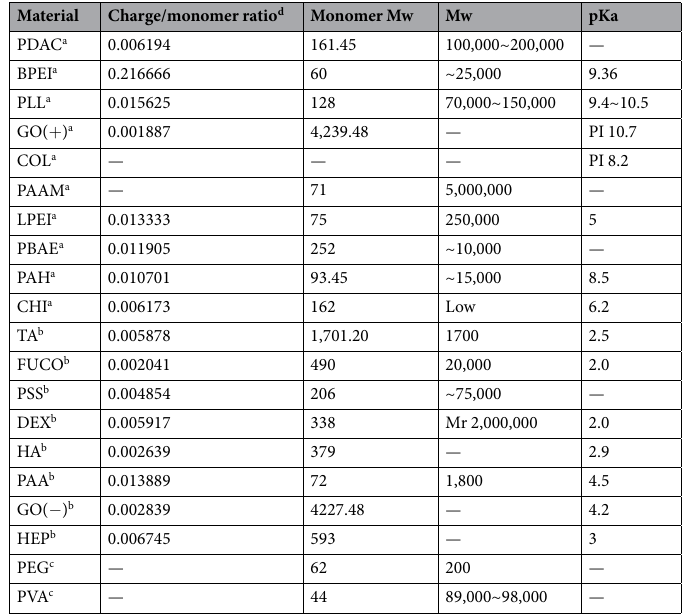
Table 1. Physicochemical properties of the polymers used. * Polycation a , polyanion b , and neutral polymer c . * The charge/monomer ratio d is calculated as the number of charges/monomer